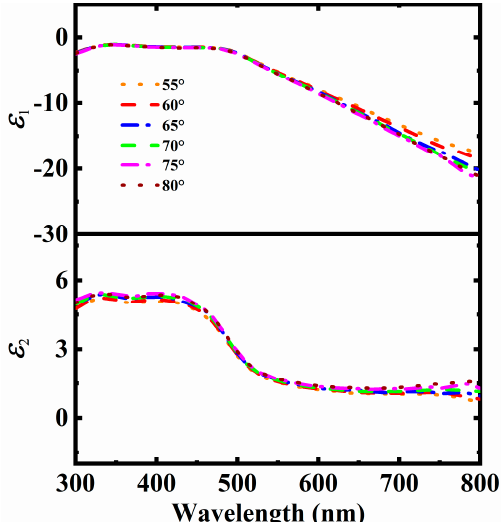
Figure 2. Dielectric functions of bulk Au determined at six incident angles.